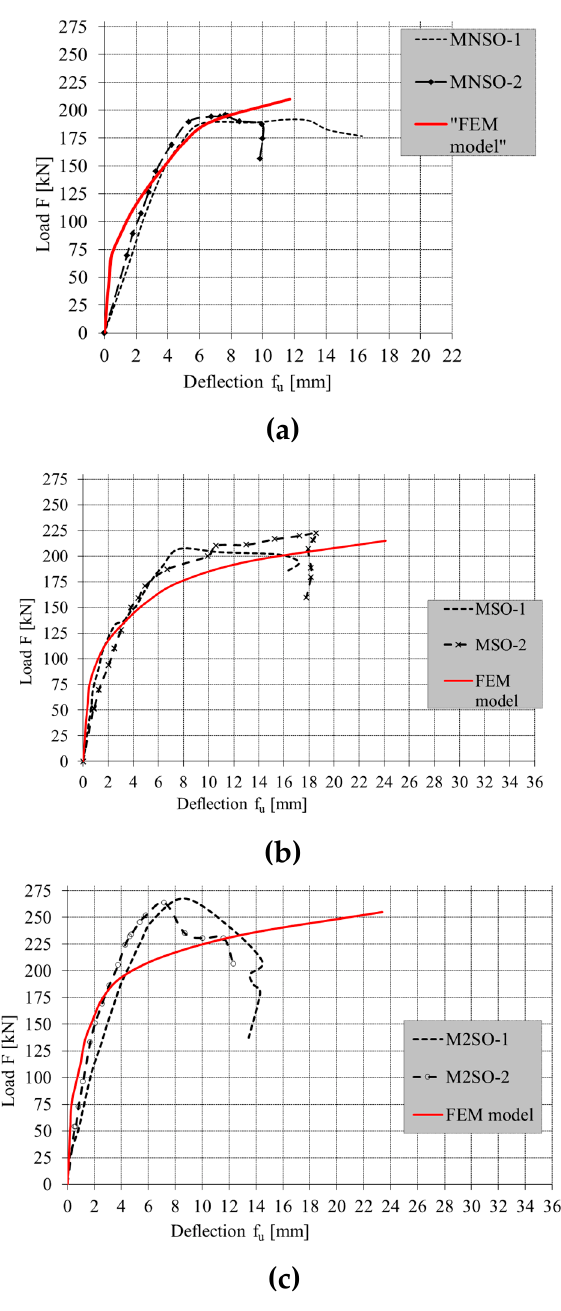
Figure 21. Compared relationship between the load and the displacement of the lintel, determined experimentally and from numerical calculations for the models of the following series: ( a ) MNSO, ( b ) MSO, ( c ) M2SO.